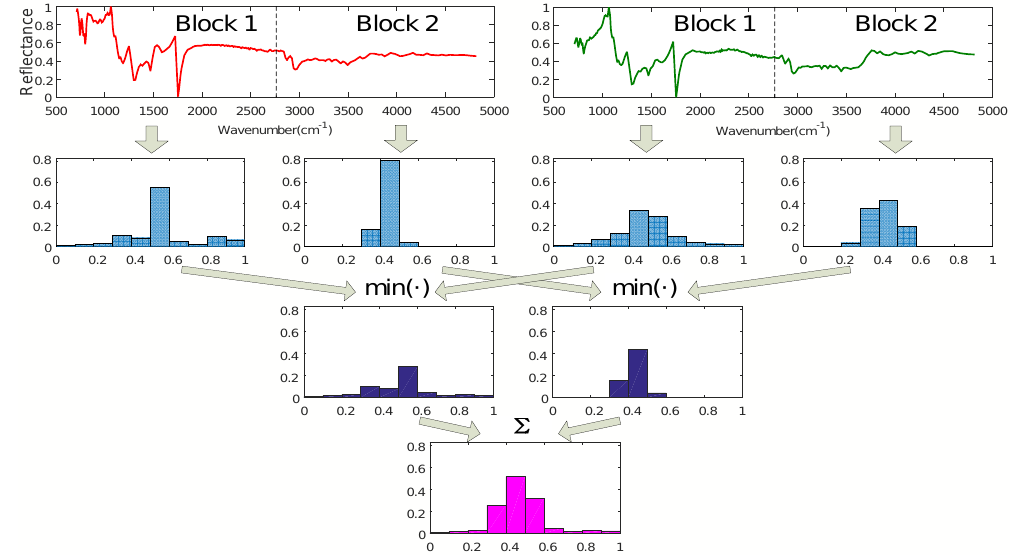
Figure 2. The spatial pyramid at Level 1 ( l = 1 ). The first row: the two spectra (Spectrum A (left), Spectrum B (right)) are divided into two sub-blocks, respectively. The second row (from the left to the right): the histogram of Block 1, Spec. A, the histogram of Block 2, Spec. A, the histogram of Block 1, Spec. B, the histogram of Block 2, Spec. B. The third row: the histogram intersection kernels. The fourth row: the summation of the histogram intersection kernels referred to in Equation (2).